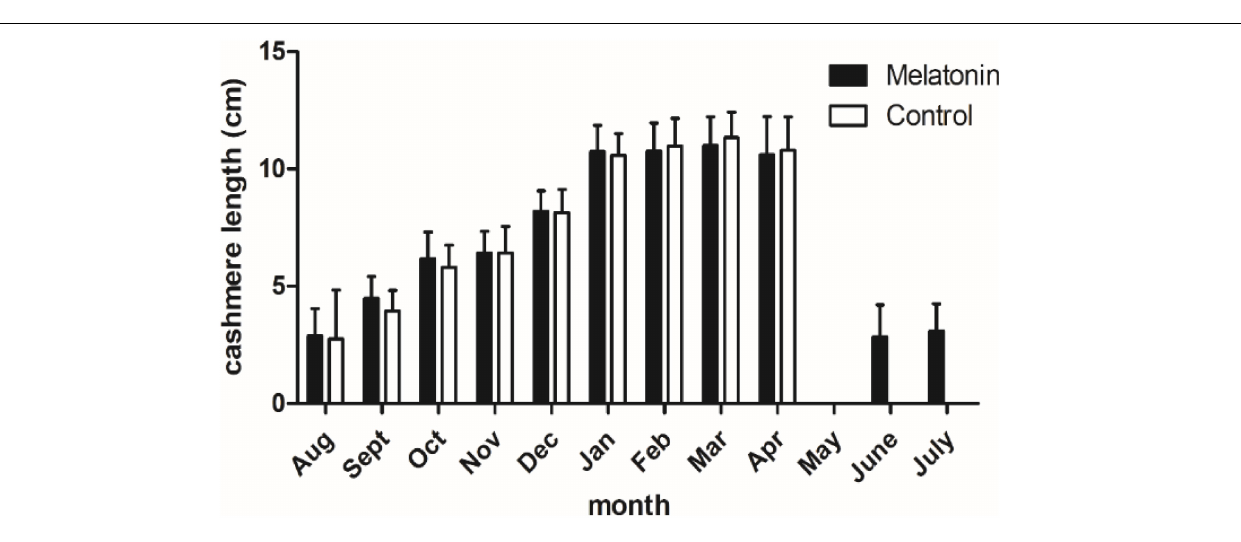
FIGURE 2 | Cashmere length of the cashmere goats in a year. Black histogram represents experimental group and white histogram represents control